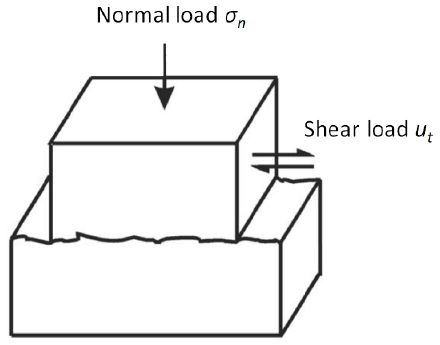
Figure 1: Shear test of rock joint interface [12]